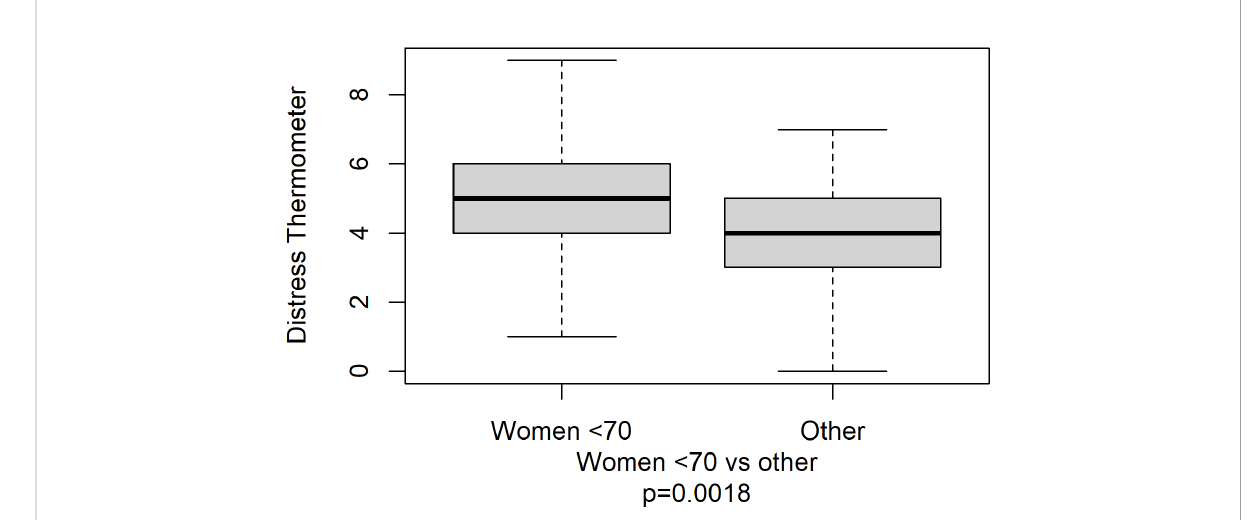
FIGURE 2 Distress thermometer ’ s boxplot by women under 70 years versus